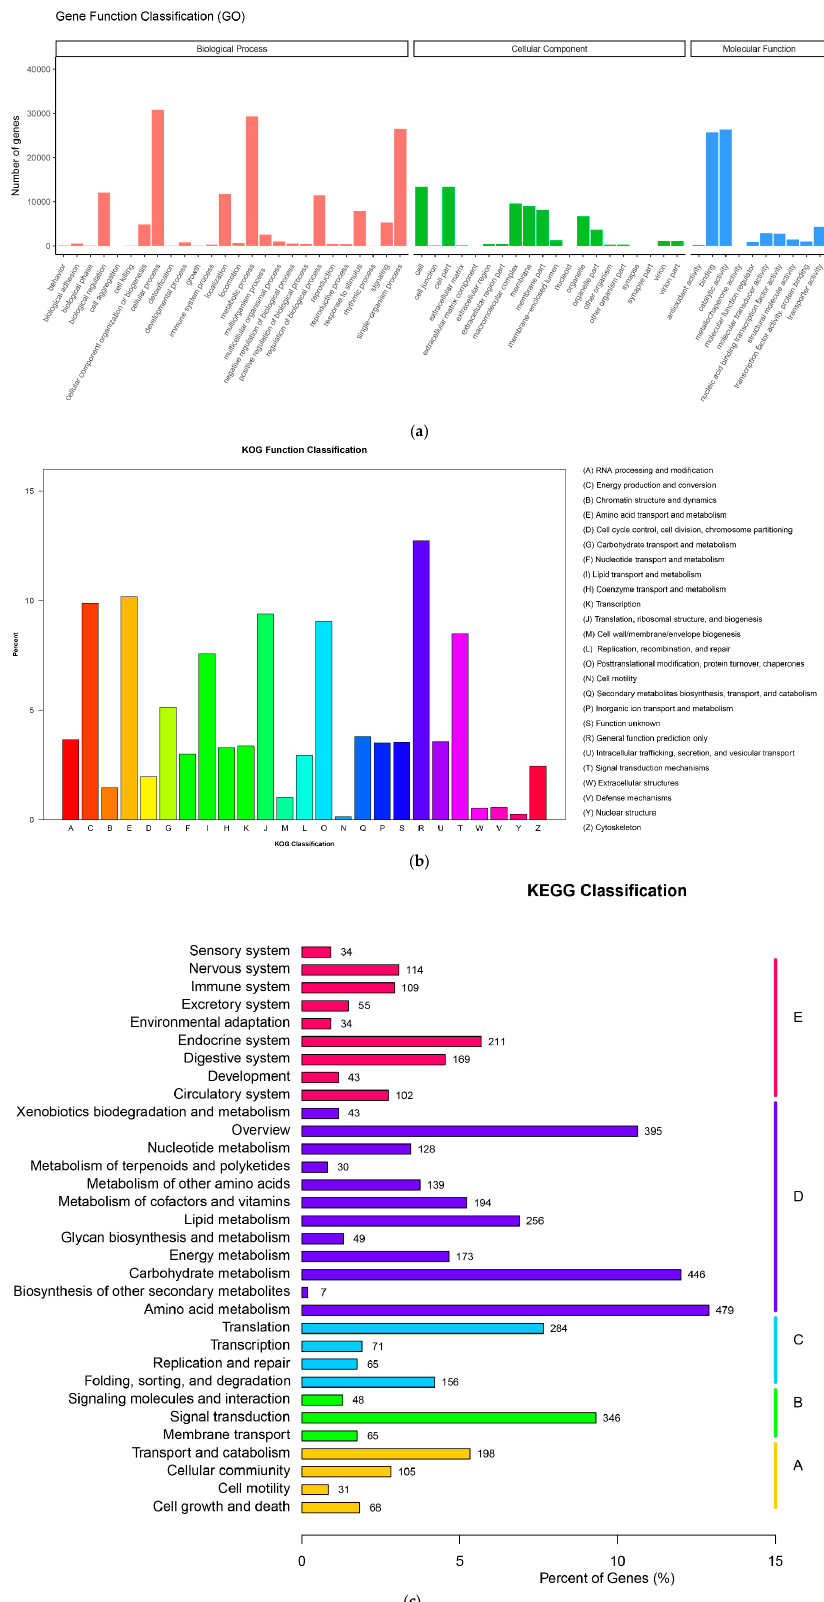
Figure 2. Results of BLASTx matches of T. yunnanensis transcriptome unigenes, gene ontology, KOG classification, and KEGG pathway annotation. ( a ) Gene ontology classifications of T. yunnanensis unigenes. ( b ) KOG classifications of T. yunnanensis unigenes. ( c ) KEGG classification of T. yunnanensis unigenes.